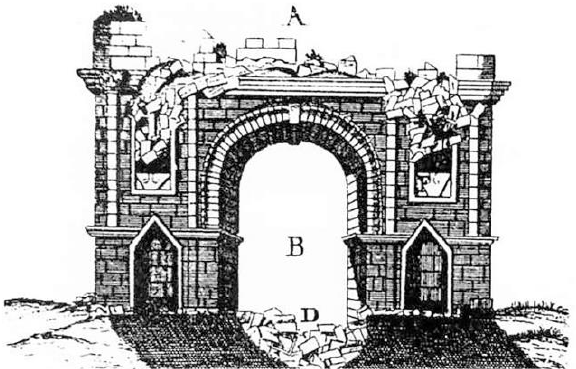
Figure 2. J. Windus’ representation of the arch (1721).